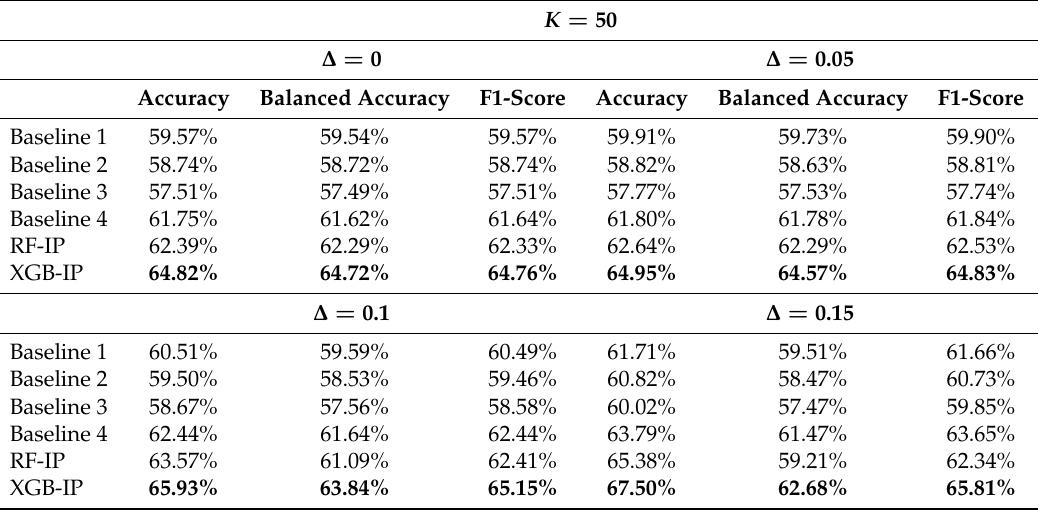
Table 7. Results of the experiments for K = 50 (best values are highlighted in